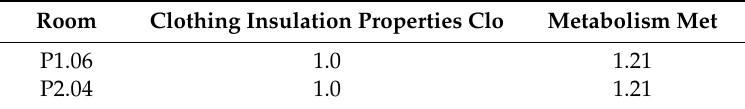
Table 4. Clo and Met values adopted for thermal comfort analyses for the transition season between 27 March and 6 April